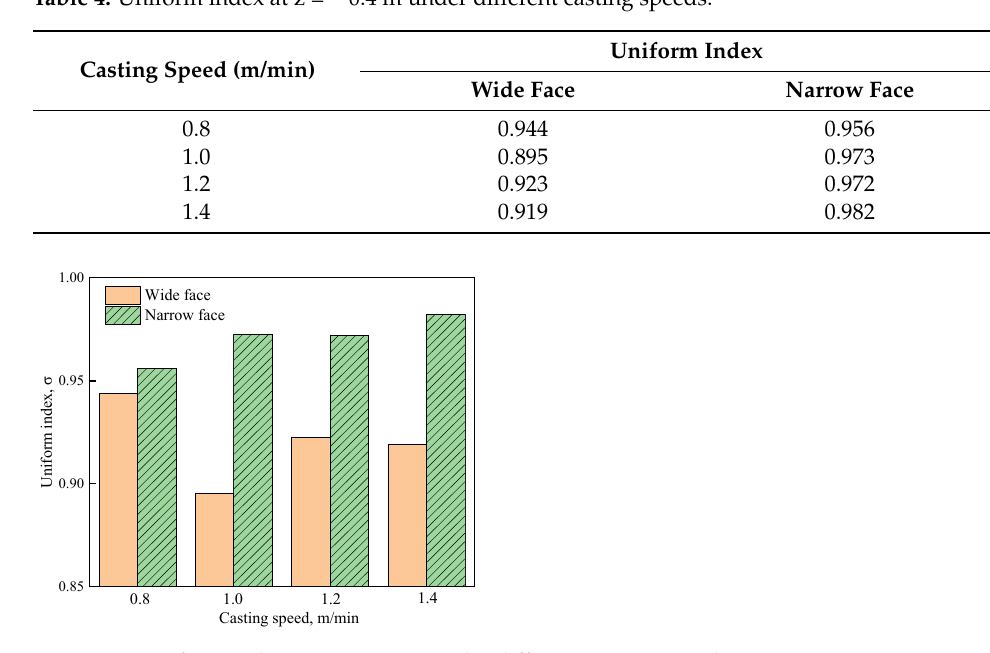
Figure 14. Uniform index at z = − 0.4 m under di ff erent casting speeds.